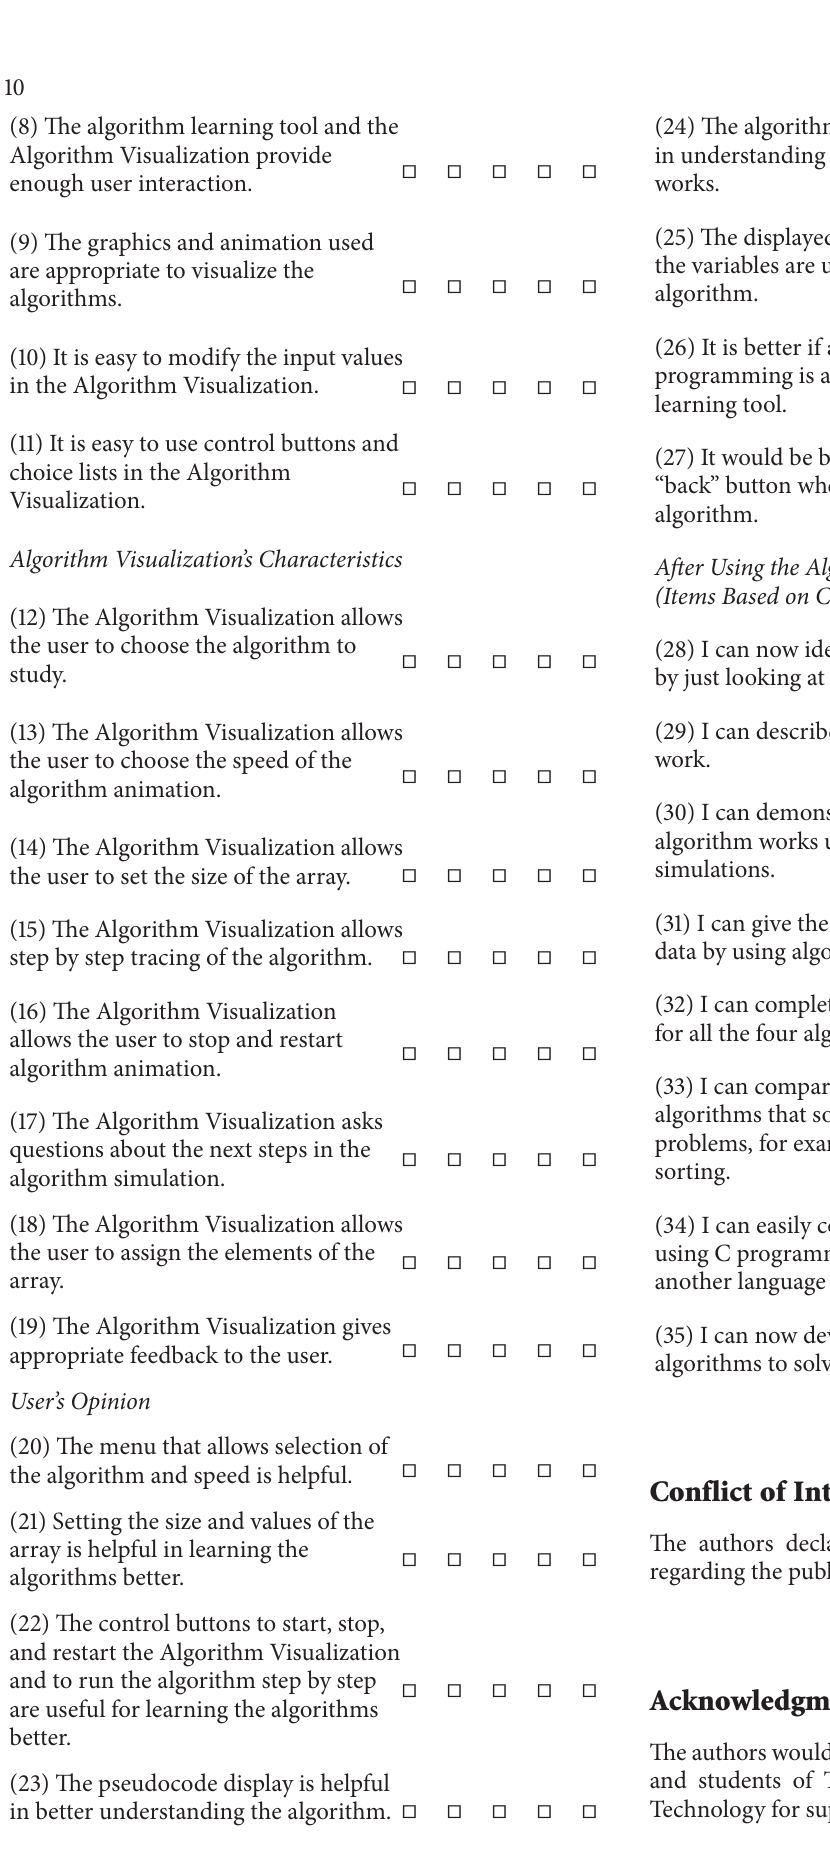
and restart the Algorithm